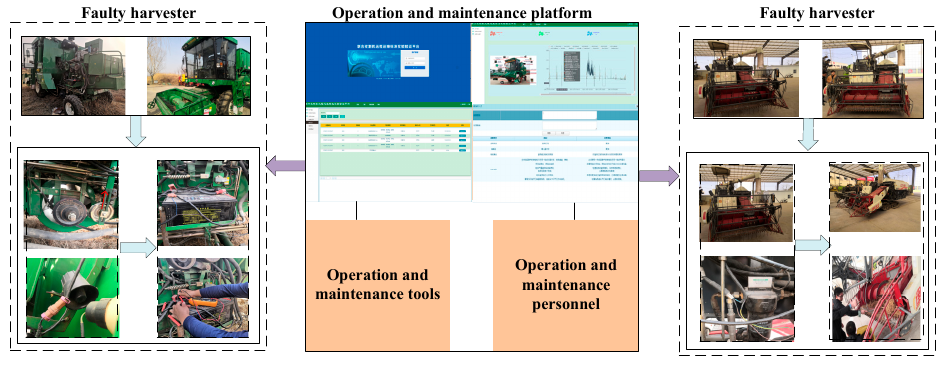
Figure 7. Harvester maintenance service test scene. Table 1. Assumed operation and maintenance resource information.